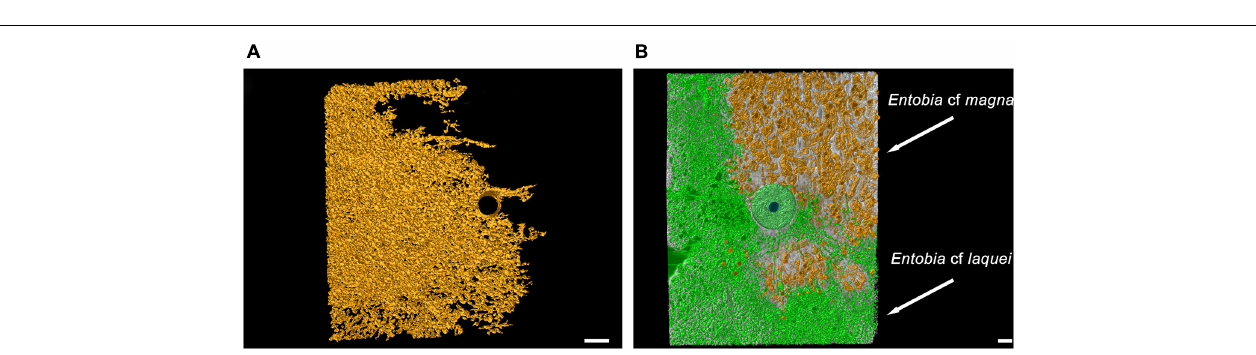
FIGURE 5 | Computed tomography graphic reconstruction of Cliona viridis bioerosion traces in travertine tiles. (A) Entobia cateniformis at P213 after 3 years of exposure. (B) Entobia cateniformis at P204 after 3 years of exposure. (C) Entobia cf ovula at MR08 after 3 years of exposure. (D) Entobia cf laquei at P204 after 12 years of exposure. Scale bars are 1 cm long.